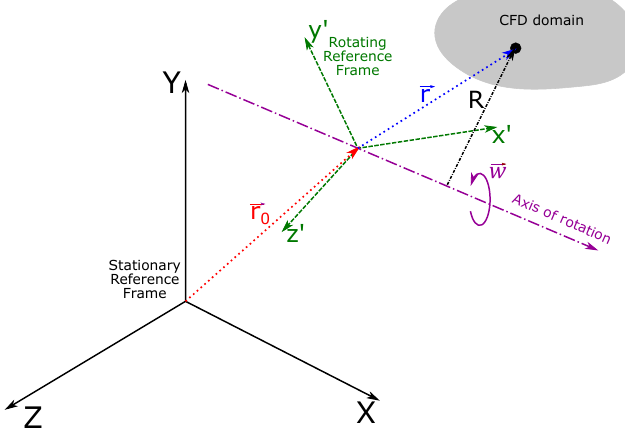
Figure 2. Stationary and rotating reference